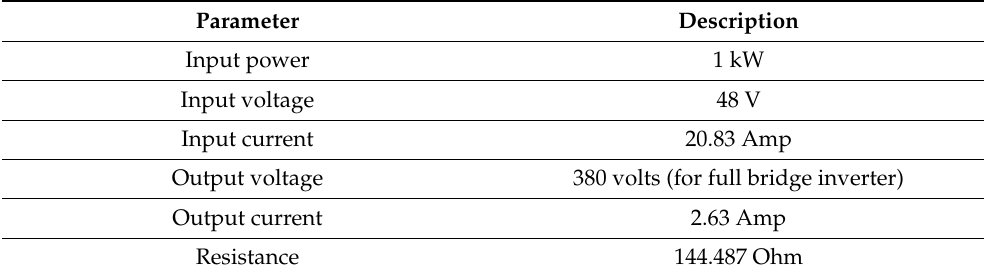
Table 1. Parameters detail used for design